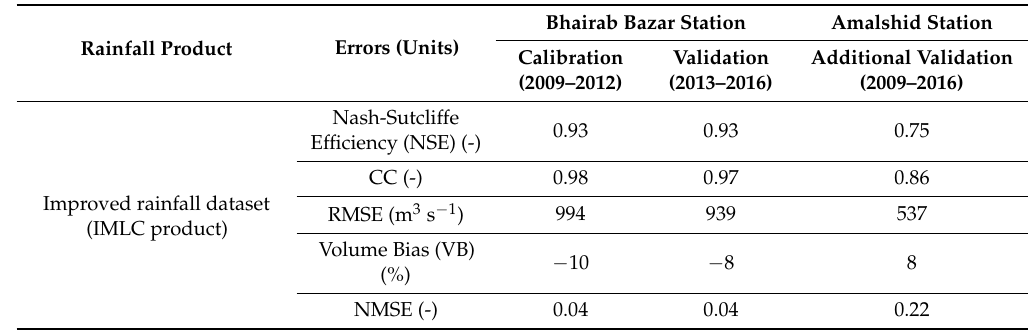
Table 4. Statistical indices used to measure the performance of the RRI model simulations in the calibration, validation, and additional-validation